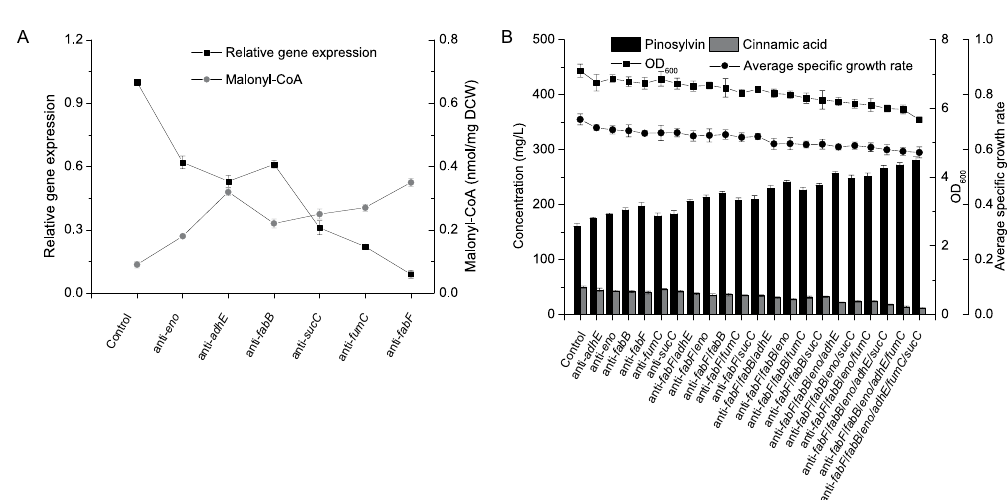
Figure 8. The effect of CRISPRi system on pinosylvin production. ( A ) To verify the efficiency of CRISPRi, the malonyl-CoA concentration and target gene mRNA level were analyzed after repressing. ( B ) Effect of different target gene repression on pinosylvin production were investigated. Control meant strains containing pinosylvin synthetic pathway without repressing. The CRISPRi system silencing different genes were subsequently transformed into the control strain to further improve pinosylvin production. Final OD 600 values and concentrations of cinnamic acid and pinosylvin were analyzed from engineered strains after 48 h. The average specific growth rate was calculated as (O 2 × V 2 − O 1 × V 1 )/10 × V 2 . O 2 meant the OD 600 value at 10 h after induction with IPTG;